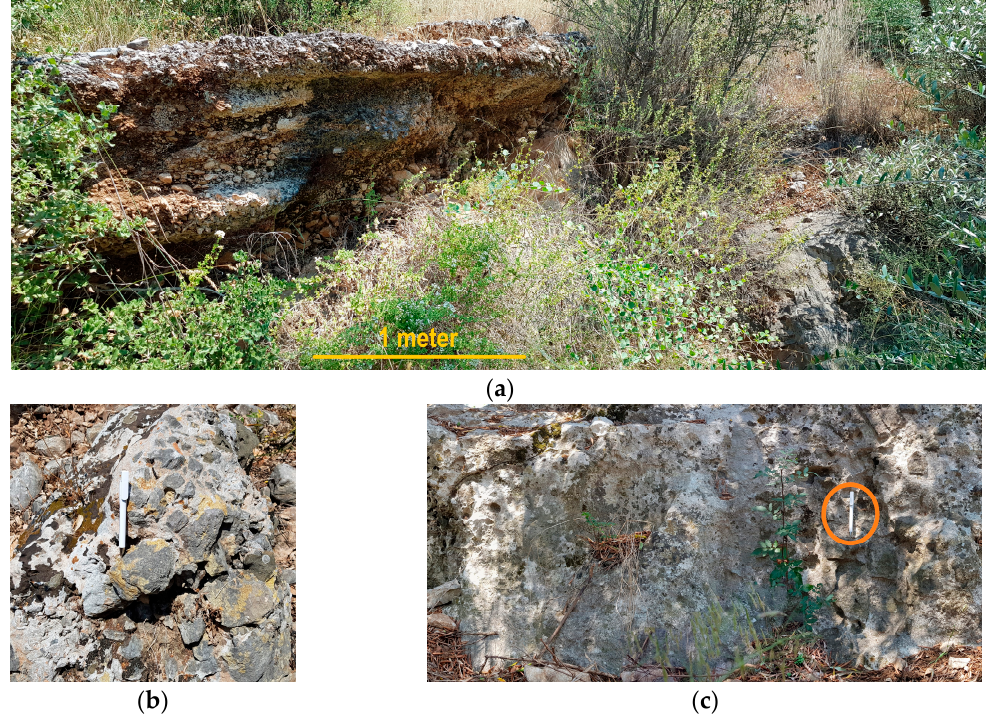
Figure 5. ( a ) Contact in the west of the geological survey area: clast supported colluvium on the left and dolomitic-limestone on the right; ( b ) poorly rounded conglomerate is at the top of the dolomitic-limestone at the center of the survey area; ( c ) dolomitic-limestone with minor karst features below the conglomerate at the center of the survey area.